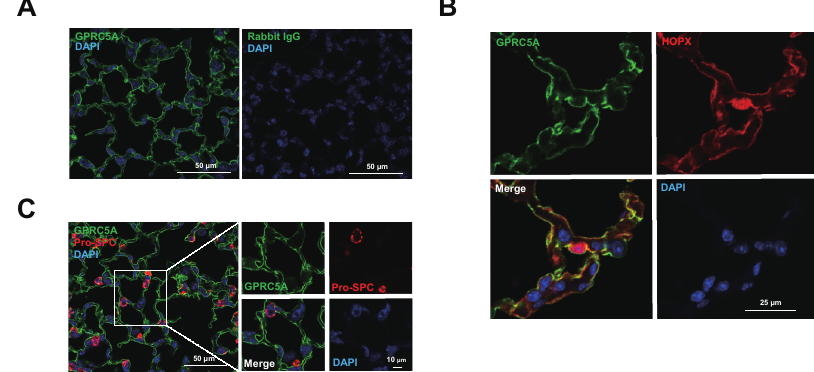
Figure 5. GPRC5A expression in mouse distal lung. ( A ) Representative single staining for GPRC5A (green) in mouse distal lung. Blue = DAPI. Rabbit IgG (right panel) was used as negative control. ( B ) Representative double staining for GPRC5A (green) and HOPX (red) in mouse distal lung. Blue = 4 (cid:48) ,6-diamidino-2-phenylindole (DAPI). Negative controls are shown in Supplemental Figure S7A. ( C ) Representative double staining for GPRC5A (green) and pro-SPC (red) in mouse distal lung. Blue = DAPI. Negative controls are shown in Supplemental Figure